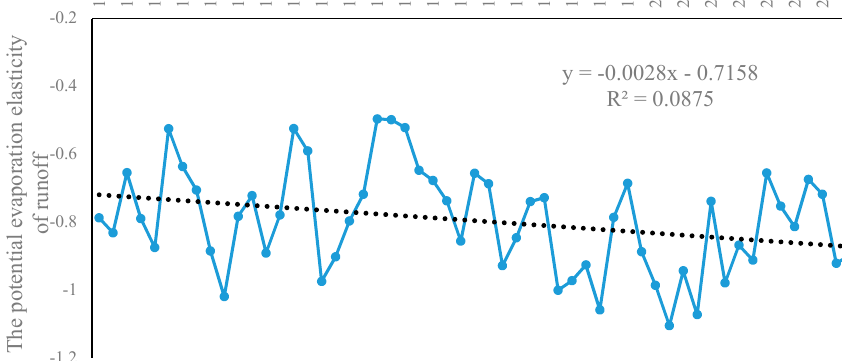
Figure 7. Changing trend of the potential evaporation elasticity of runoff.